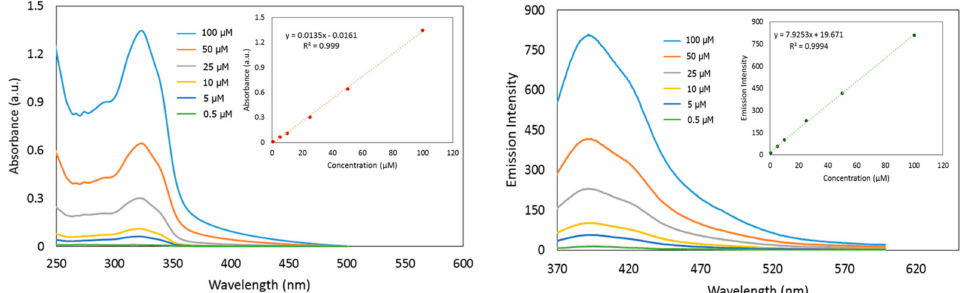
Figure 6. ( Left ) Absorption spectra of 5 at different concentrations (0.5, 5, 10, 25, 50, 100 µ M) in HEPES buffer solution pH 7.4 (contain 0.8% MeCN). The inset displays the linear relationship between the absorbances at 323 nm and the concentrations of 5 . ( Right ) Fluorescence spectra of 5 (excited at 350 nm) at different concentrations (0.5, 5, 10, 25, 50, 100 µ M) in HEPES buffer solution pH 7.4 (contain 0.8% MeCN). The inset displays the linear relationship between the emission intensities at 393 nm and the concentrations of 5